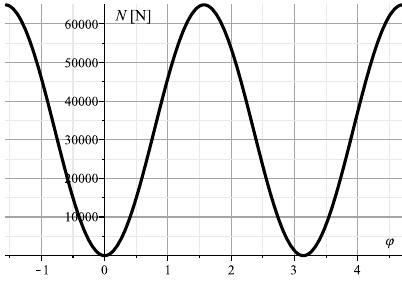
Figure 26: Plot of N ( φ ) (Example 5.3).